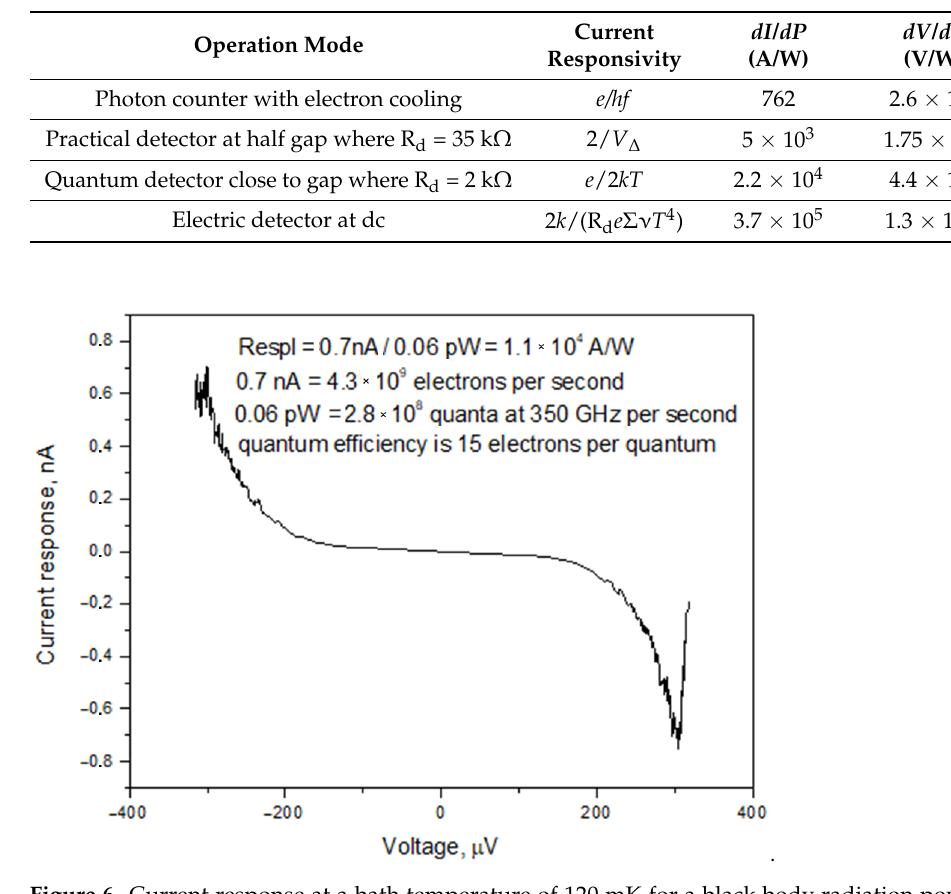
Figure 6. Current response at a bath temperature of 120 mK for a black body radiation power of 60 fW.